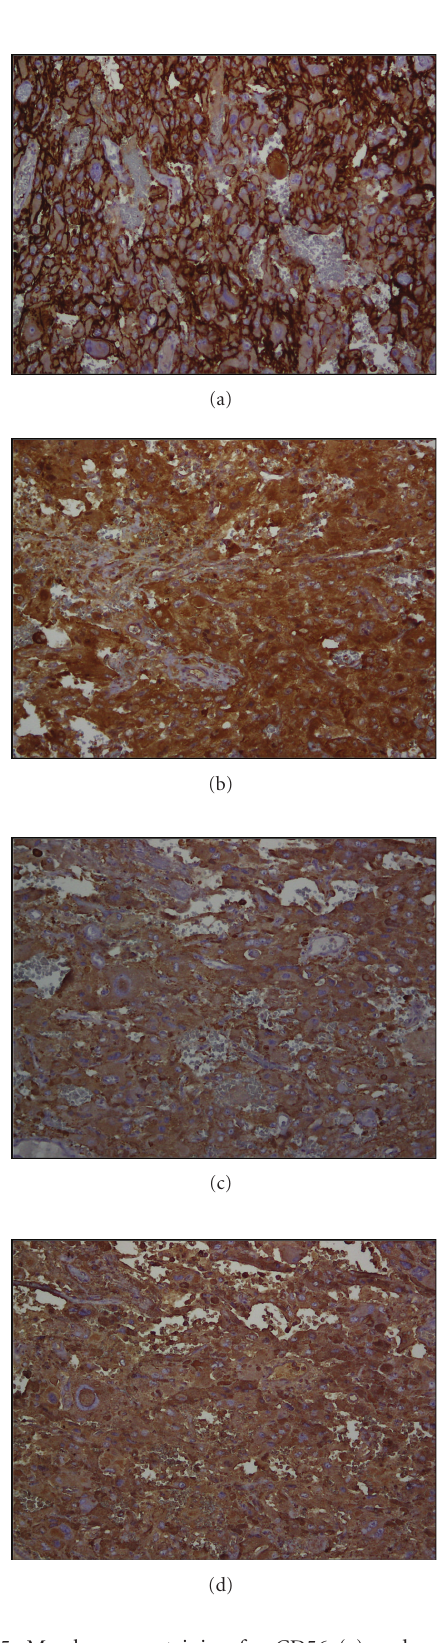
Figure 5: Membranous staining for CD56 (a) and cytoplasmic staining for neuron-specific enolase (b), synaptophysin (c), and chromogranin (d) in tumor cells (H & E;